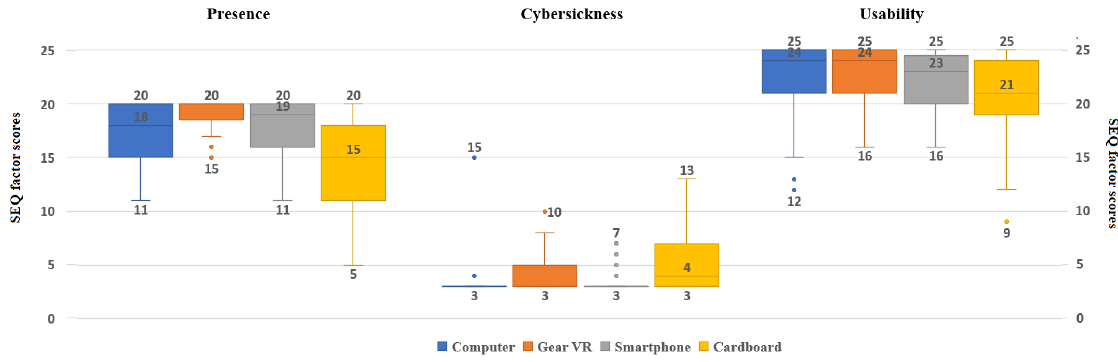
Figure 5. Box plot of factor scores in different devices.